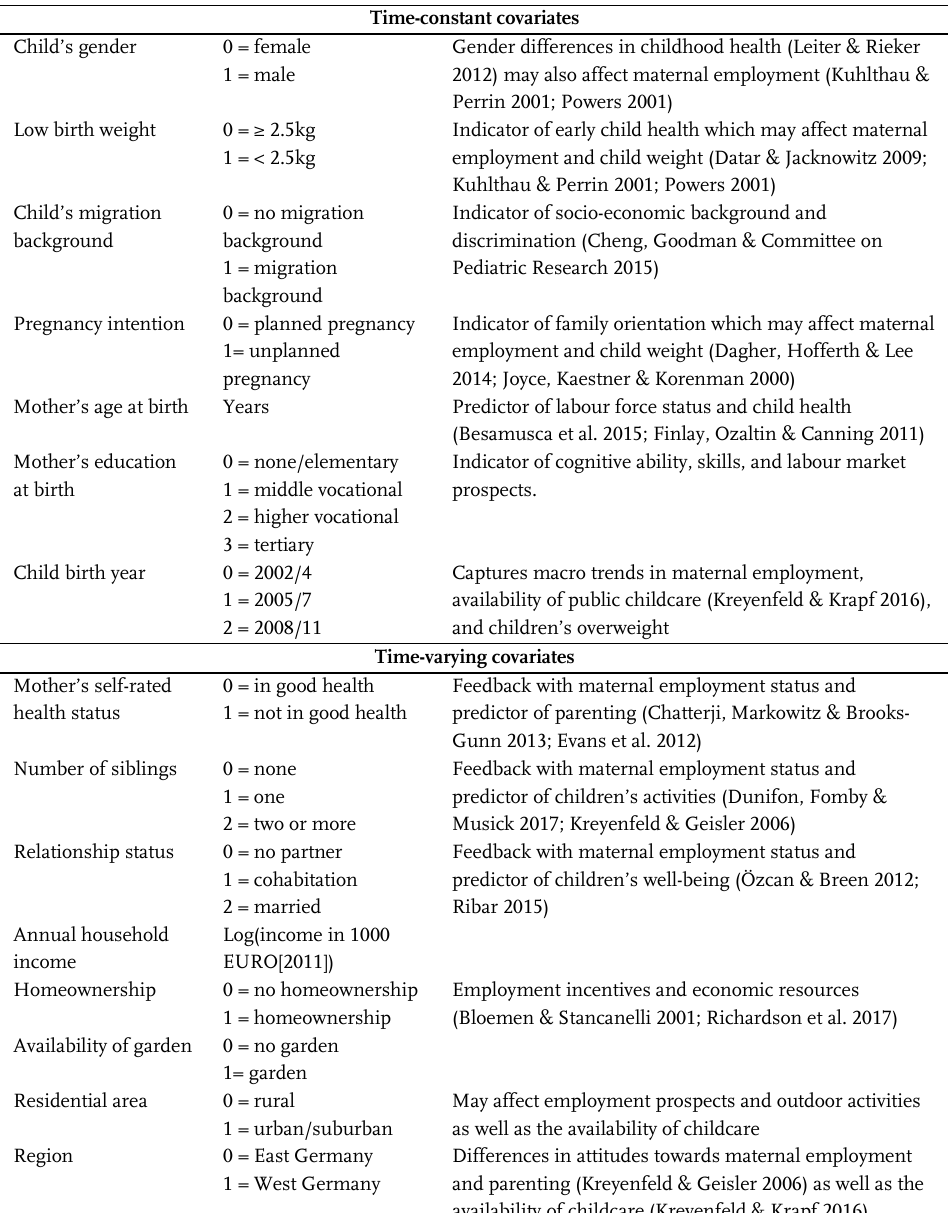
Table 1 : Control